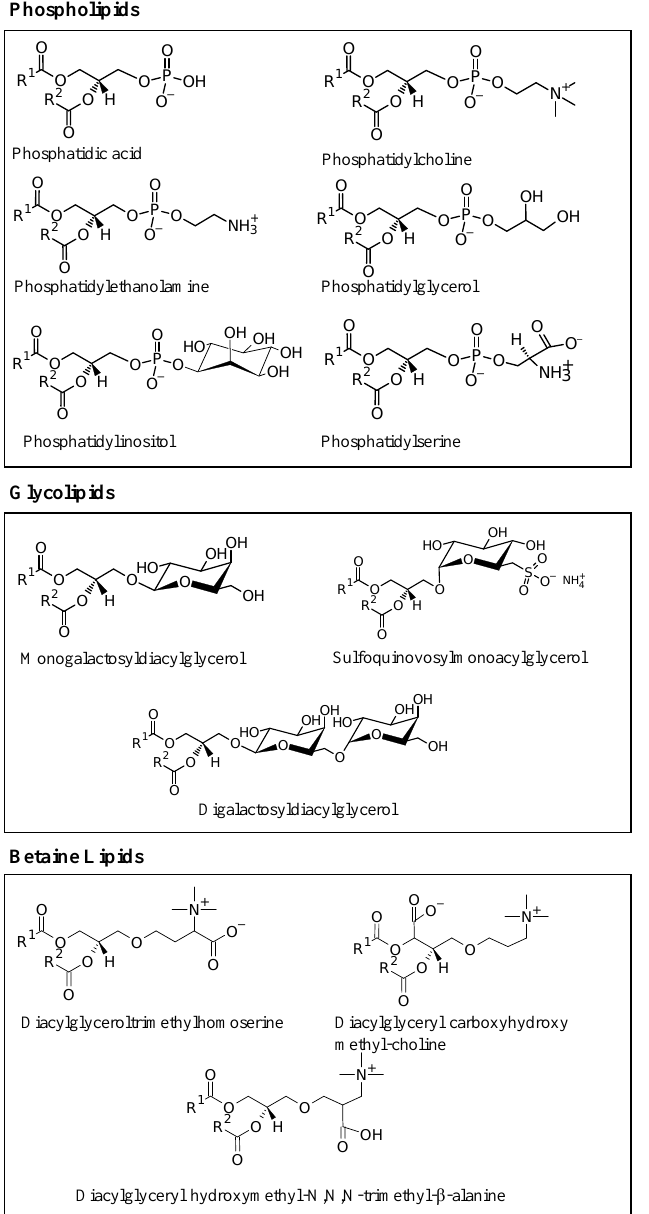
Figure 3. Main classes of polar lipids found in microalgae: glycerophospholipids (or phospholipids), glycoglycerolipids (or glycolipids), and betaine lipids.